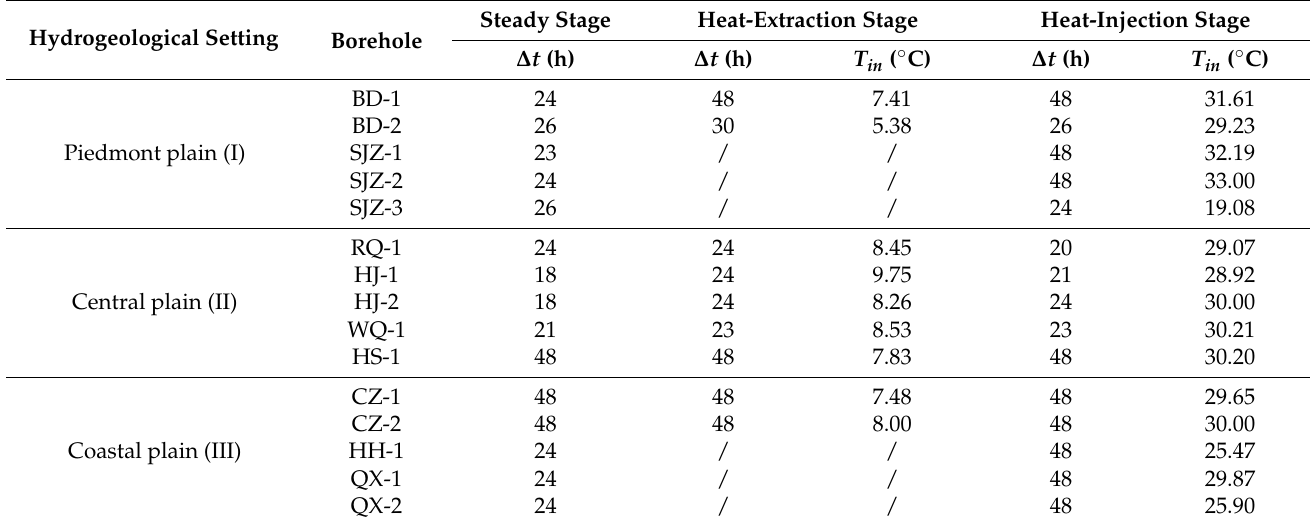
Table 3. Data related to the conducted CHTM-based TRT of all boreholes.